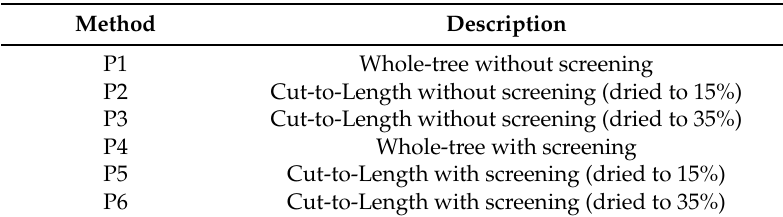
Table 1. Harvesting